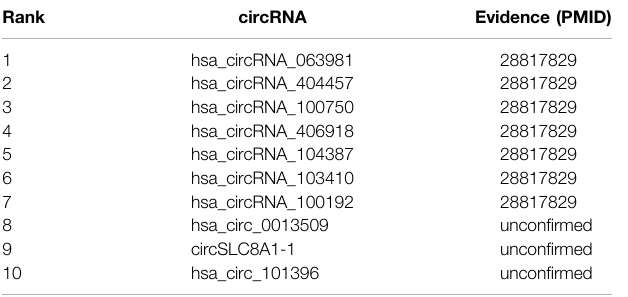
TABLE 3 | Top 10 candidate circRNAs related to diabetes retinopathy.